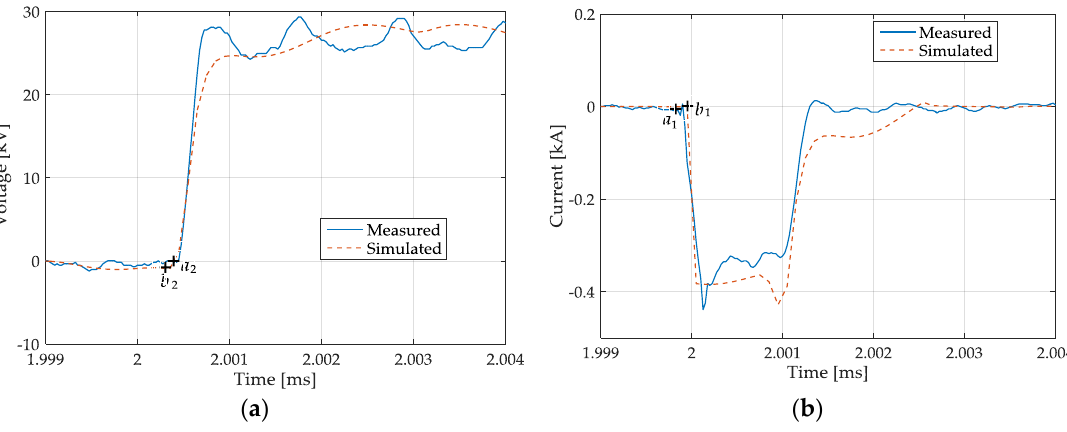
Figure 7. The zoomed-in views of the voltages and currents at the high side of TX2: ( a ) voltages; ( b ) currents.